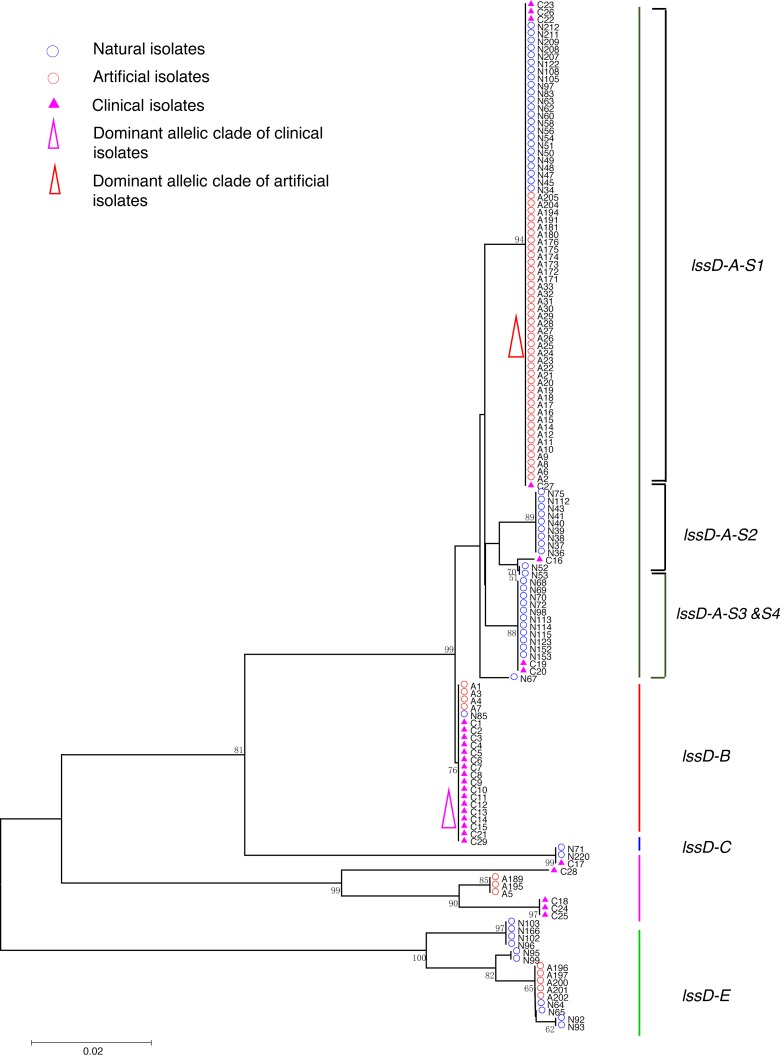
Neighbor-Joining tree of L. pneumophila isolates from DNA sequences of lssD locus.Strain types, source natures and geographic locations of these isolates were shown in Table S1. Bootstrap support values (1,000 replicates) for nodes higher than 50% are indicated next to the corresponding node. Five main groups of the clades could be found.